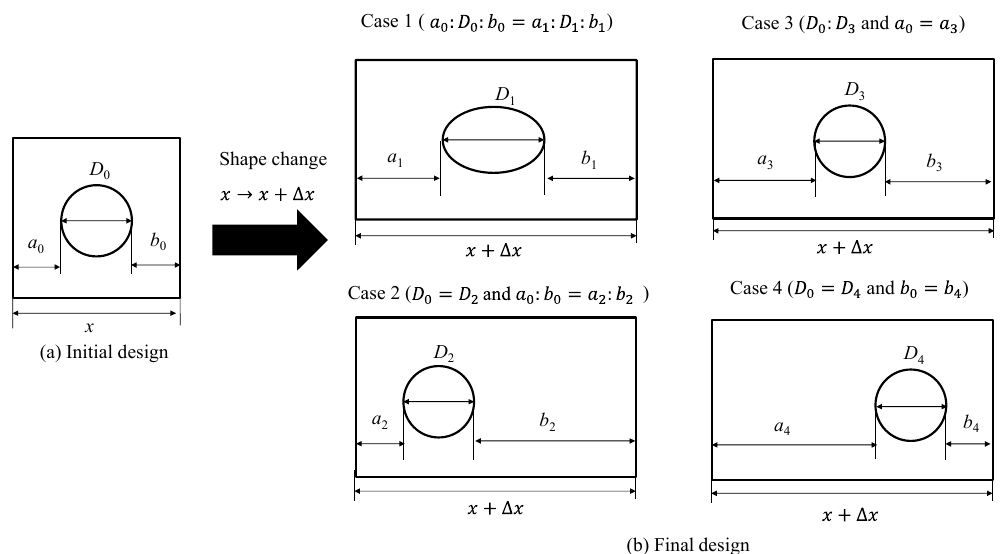
Figure 1. Control of inside form in the topological optimization problem. ( a ) Initial design, ( b ) Final design.